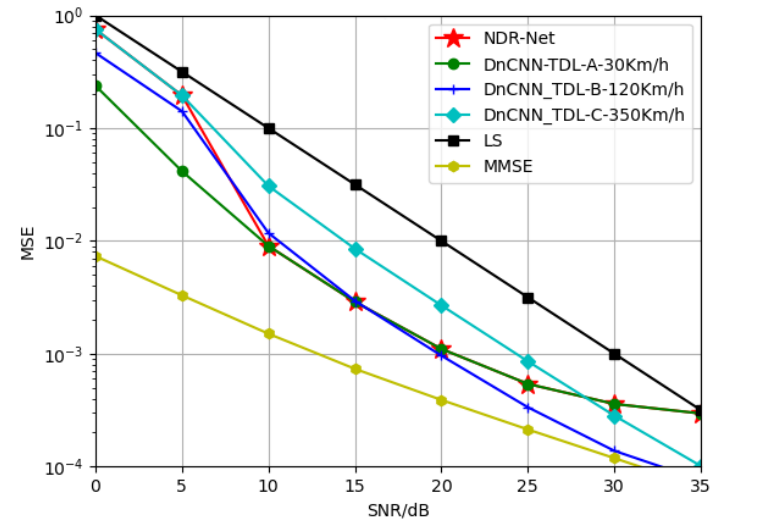
Figure 9. Generalization performance of different channel estimators when the training SNR = 15 dB and the testing channel is TDL-A-30Km/h.